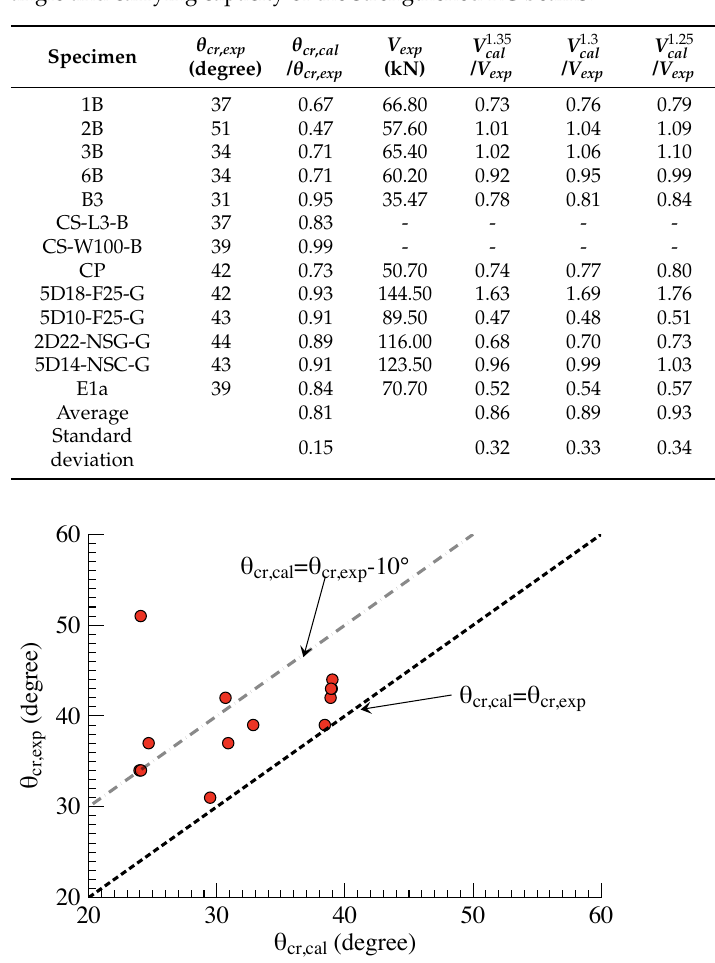
Table 3. Comparisons between the calculational results and experimental results about cracking angle and carrying capacity of the strengthened RC beams.